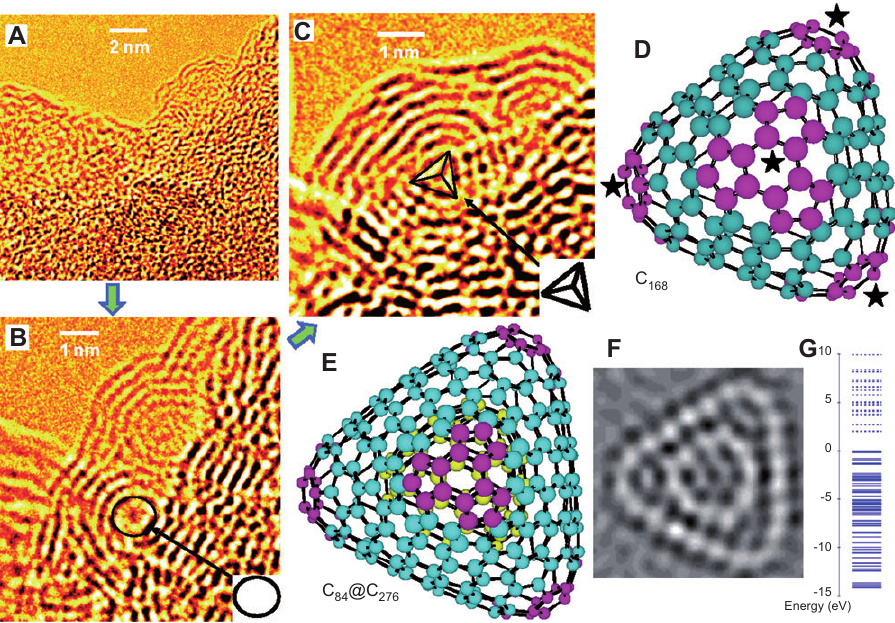
Figure 12 (A) HREM image of as-prepared amorphous carbon. (B) Two carbon onions produced from amorphous carbon (A) by electron- beam irradiation for 20 min. (C) Tetrahedral carbon onion produced from (B) by electron-beam irradiation for 30 min. (D) Basic atomic structure of tetrahedral onion (C of